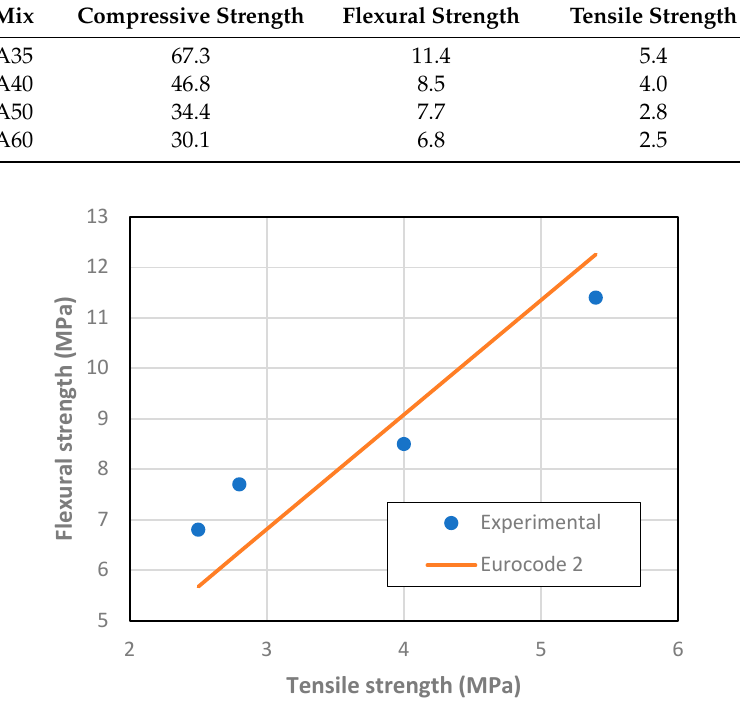
Table 2. Matrix strength (MPa).